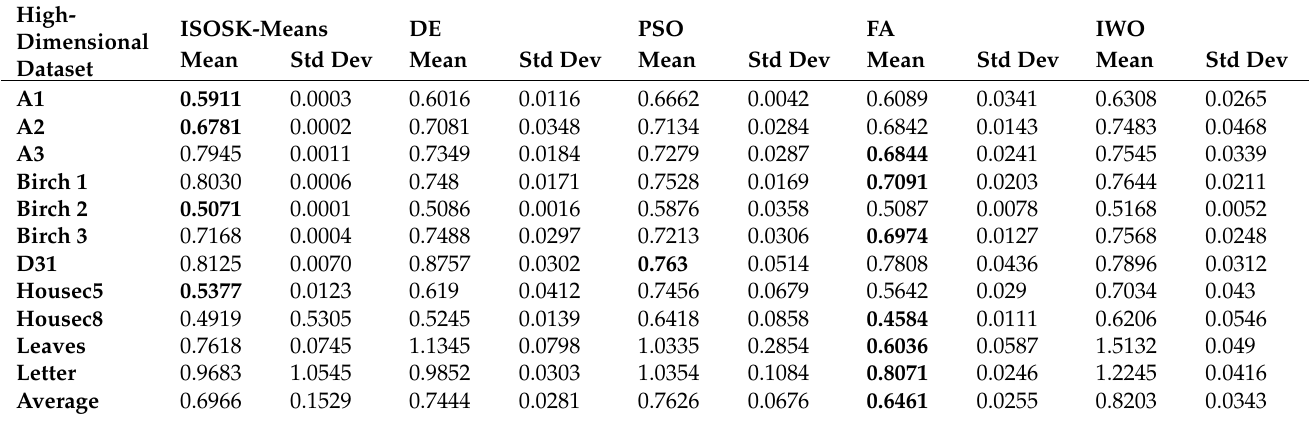
Table 10. Performance comparison of ISOSK-means with other non-hybrid metaheuristic algorithms on high-dimensional datasets.